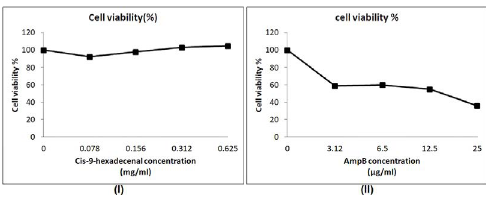
Fig. 5. Cytotoxicity study of cis-9-hexadecenal in comparision to amphotericin B using MTT assay. (l) and (ll) are the cell viability assay at various concentrations of cis-9-hexadecenal and amphotericin B